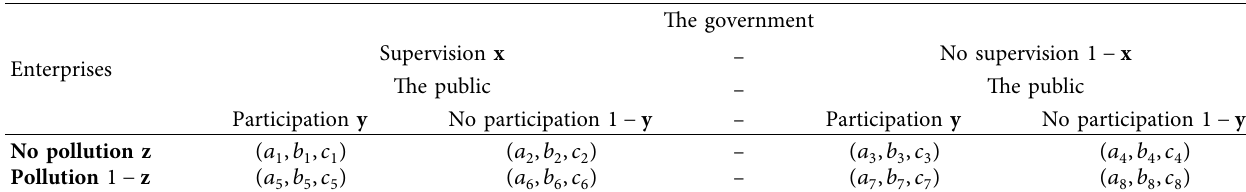
Table 2: Tripartite game matrix of government, public, and enterprise.